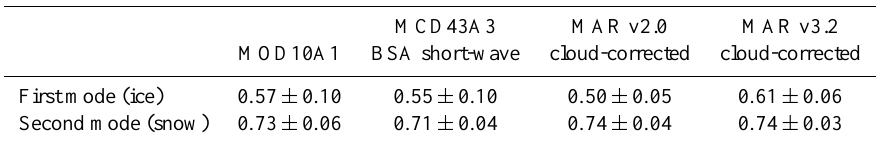
Figure 10. Scatter plots of 2000–2012 JJA mean albedo [unitless] vs. automatic weather station (GC-Net and K-Transect) albedo: (a) MOD10A1 16-day averages vs. 16-day in situ (b) MCD43A3 BSA SW vs. 16-day in-situ (c) MAR v3.2 clear-sky 16-day vs. 16- day in situ (d) MOD10A1 vs. in situ (daily) and (e) MAR v3.2 vs. in situ (daily). As for Fig. 9, blue points indicate locations within the accumulation zone as defined using MAR v3.2. Table 5. Mean and standard deviation for the best fit to the distributions of ablation area albedo shown in Fig. 11 (assuming that the appropriate distribution is a combination of two normal